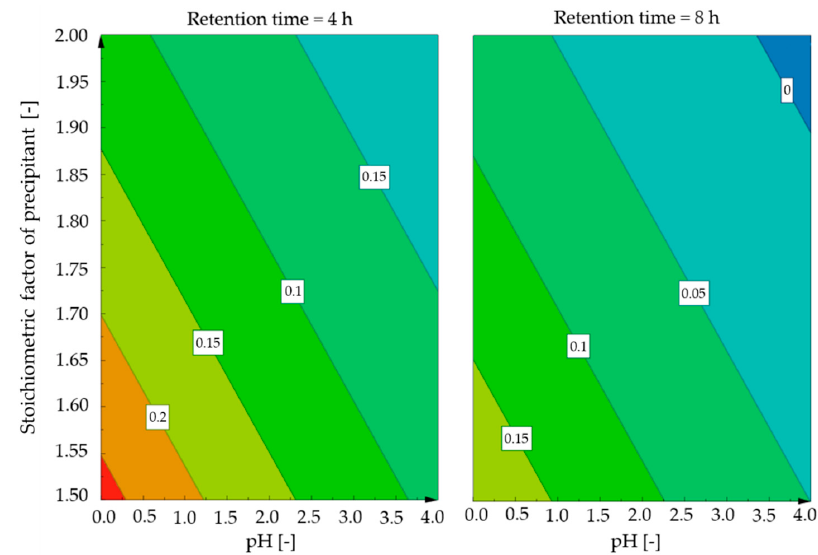
Figure 9. Statistical evaluation of the residual dissolved concentrations (g/L) of nickel for 4 and 8 h retention time, respectively.